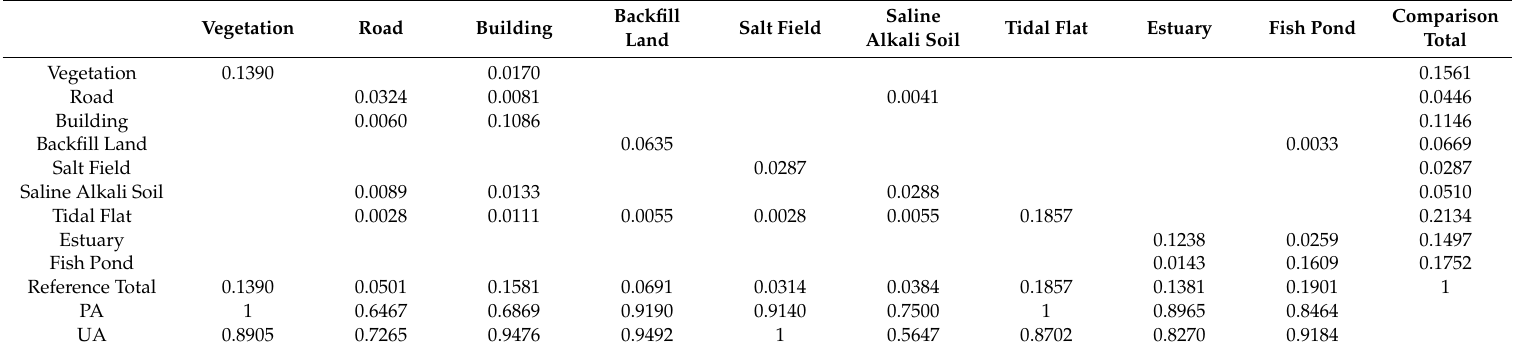
Table 9. Estimated population matrix of the k-NN method in the WV-2